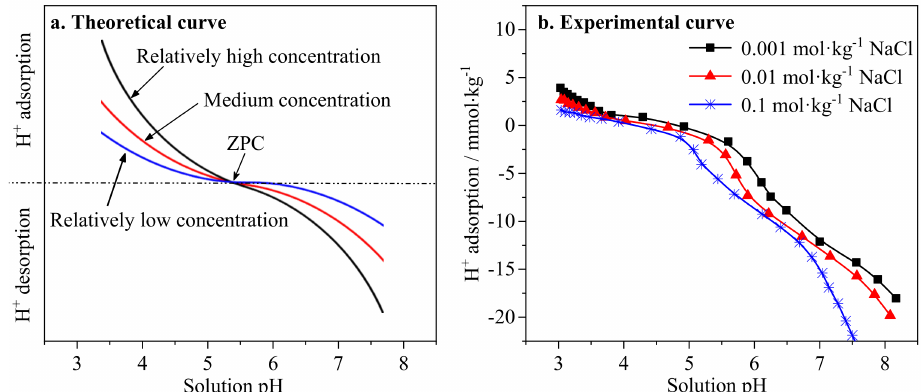
Figure 6. Acid–base titration curves of clay minerals with variable charge under different ionic strengths. ( a ) Theoretical curve; ( b ) Experimental